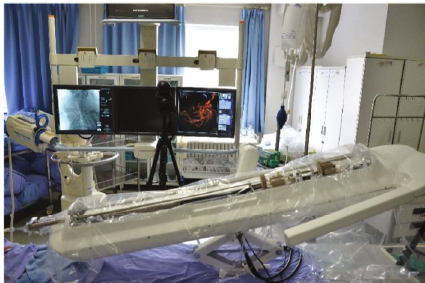
Figure 1: The manipulator arm of the slave end.